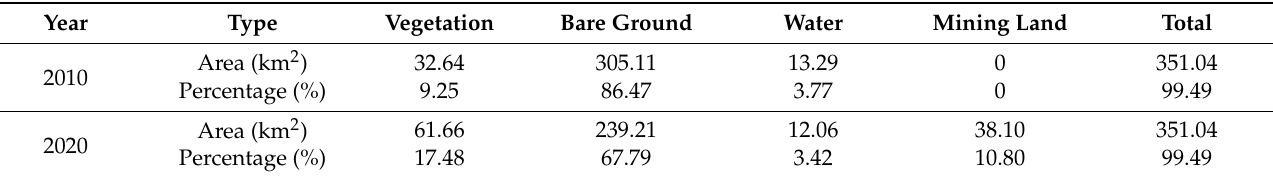
Table 5. Ecological resources in the monitoring area of Sino Iron.